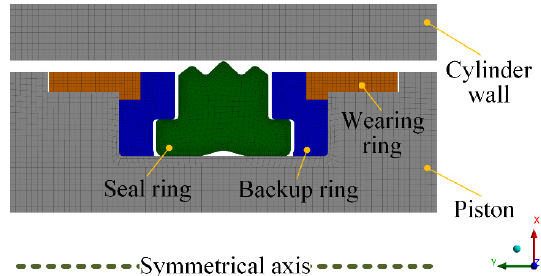
Figure 2. The axisymmetric model established in the FEA software.